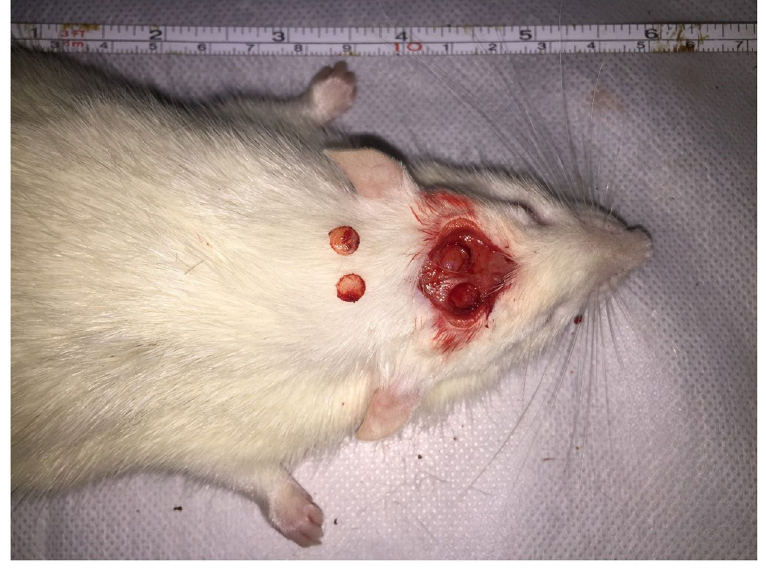
Figure 2. Two bilateral critical-sized calvarial defect models without perichondrium were created.